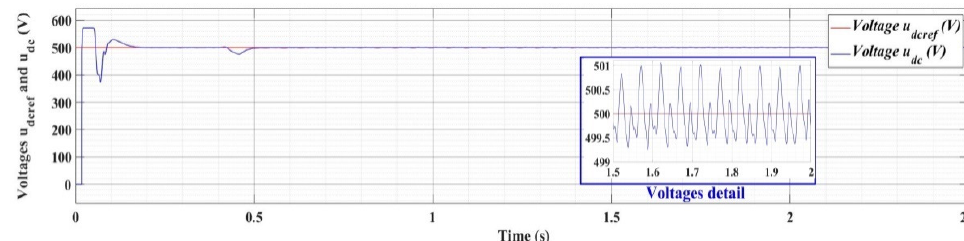
Figure 40. The time evolution of the u dc voltage for irradiance and temperature using SMC- and SYN-type controllers for a 13 kvar load (signal evolution of the type 2 PV array).